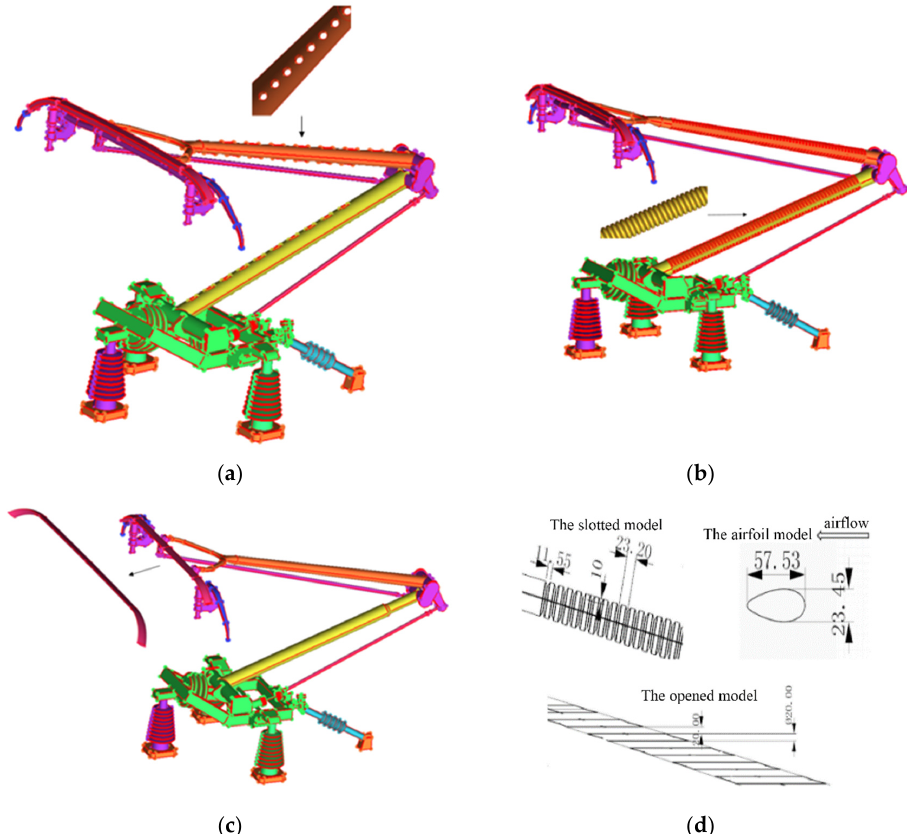
Figure 1. Schematic diagram of the optimized scheme in the upper part of the pantograph. ( a ) Opened ULA. ( b ) Slotted ULA. ( c ) The airfoil bow head. ( d ) Dimension description.